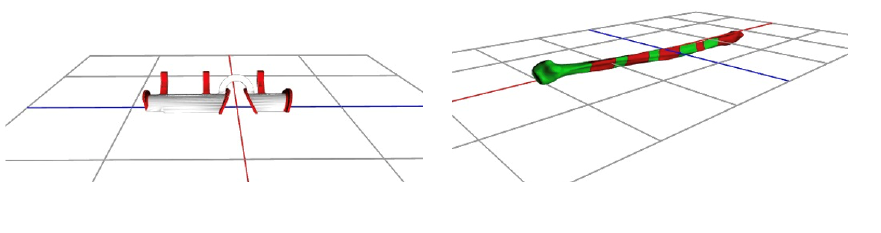
Figure 4. Model Target of surgical guide and